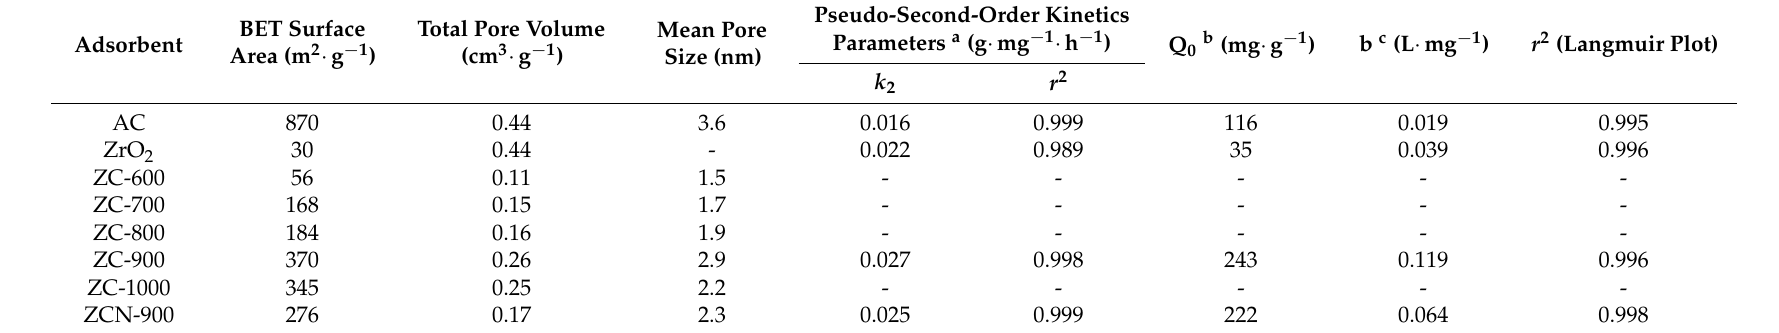
Table 1. Textural properties and the results for the CV adsorption on different